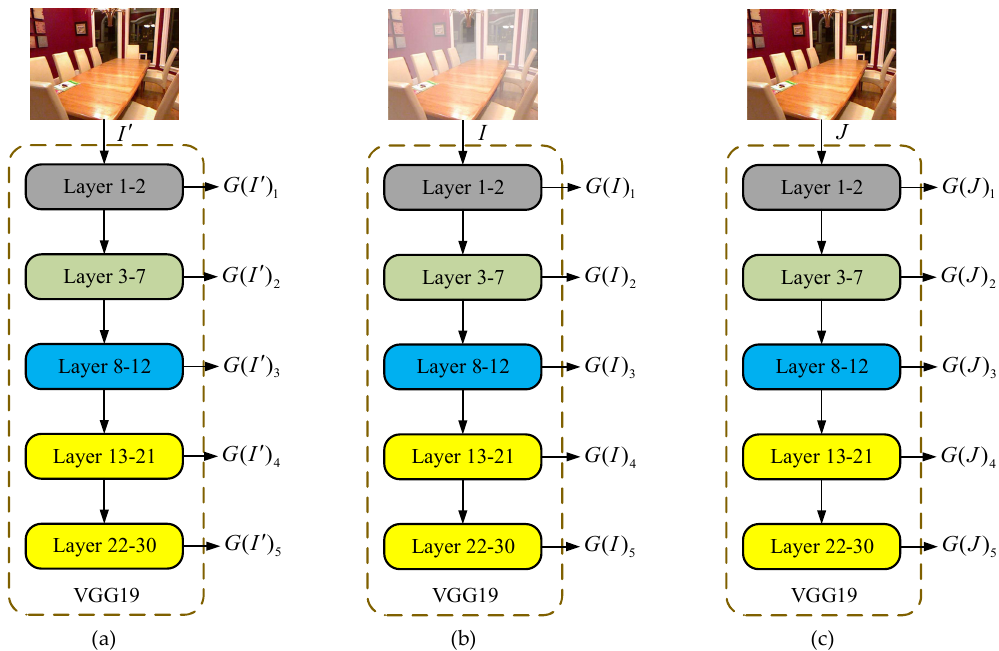
Figure 4. We select the intermediate knowledge in VGG19 to construct the internal feature space. We adopt features from the 2nd, 7th, 12th, 21st, and 30th layers of VGG19 model. ( a ) The hidden features of anchors. ( b ) The hidden features of negative samples. ( c ) The hidden features of positive